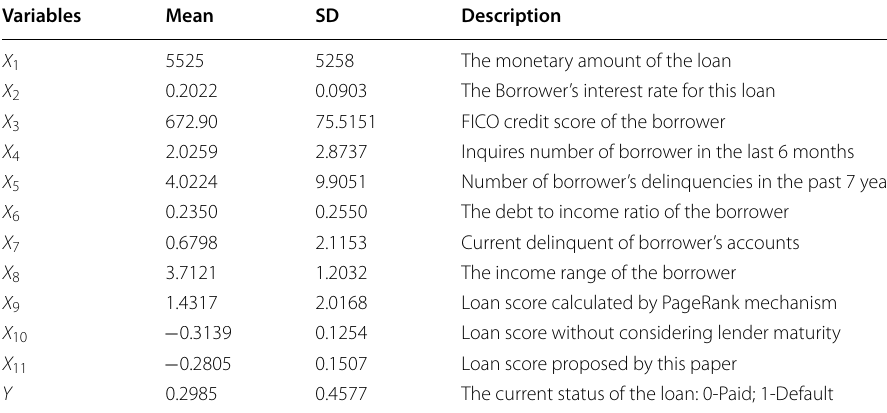
Table 2 Description and statistics of